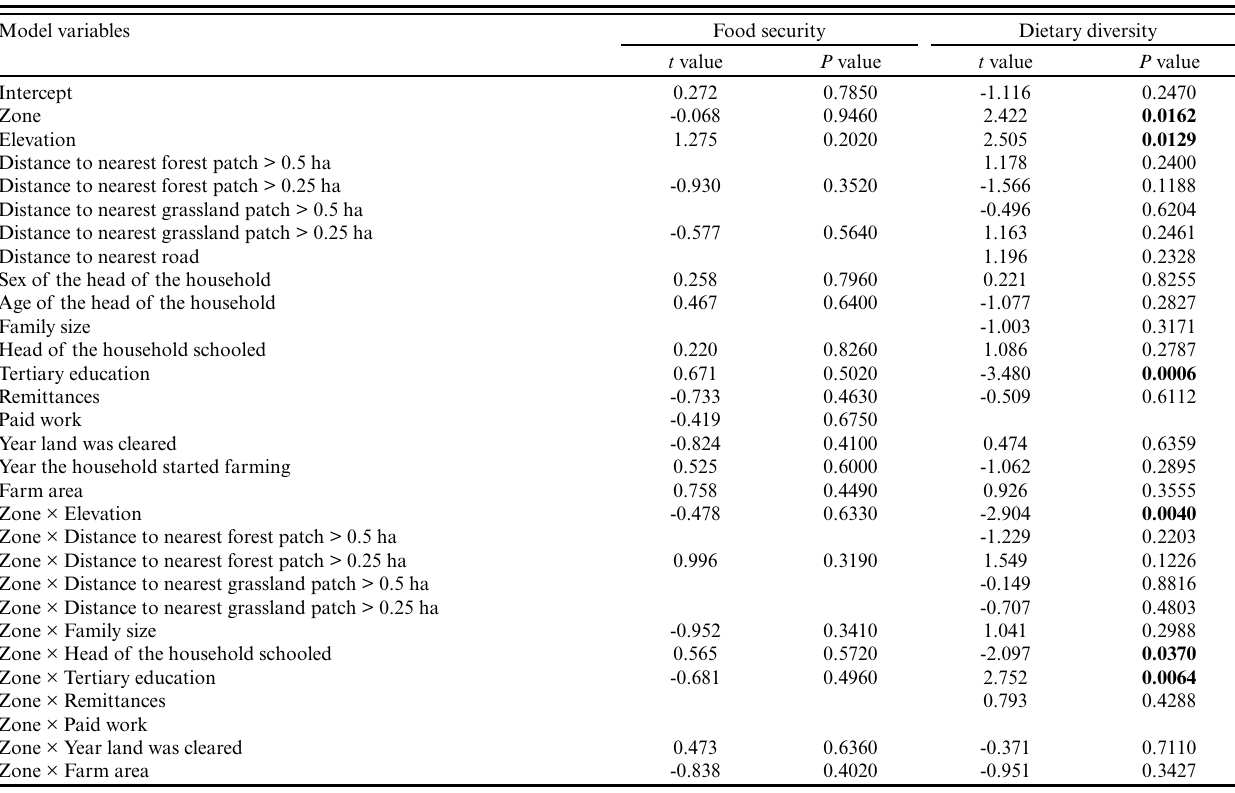
Table 3 . Summary of the results of Model 1 for explaining the variability in food security (months of adequate food provisioning) and dietary diversity (household dietary diversity score). Significant effects ( P < 0.05) are shown in